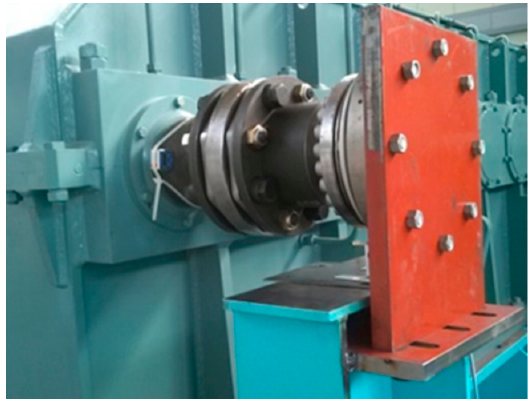
Figure 13. Torque meter installed on the test rig.